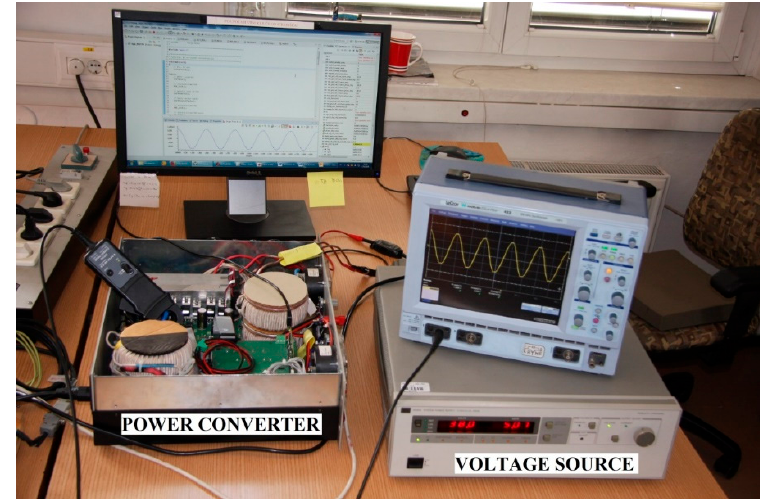
Figure 6. Experimental setup photo. Table 2. Parameters of experimental setup.